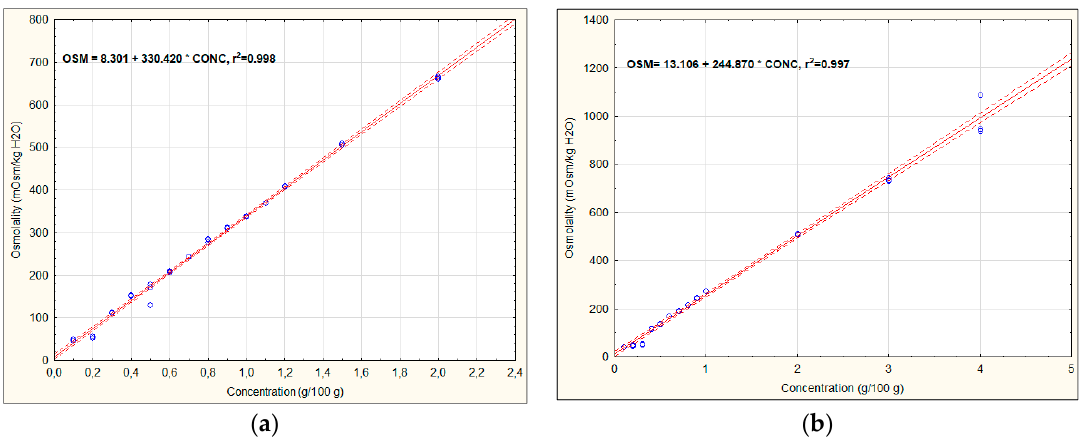
Figure 1. Sodium chloride ( a ) and potassium chloride ( b ) osmolalities in aqueous solution.